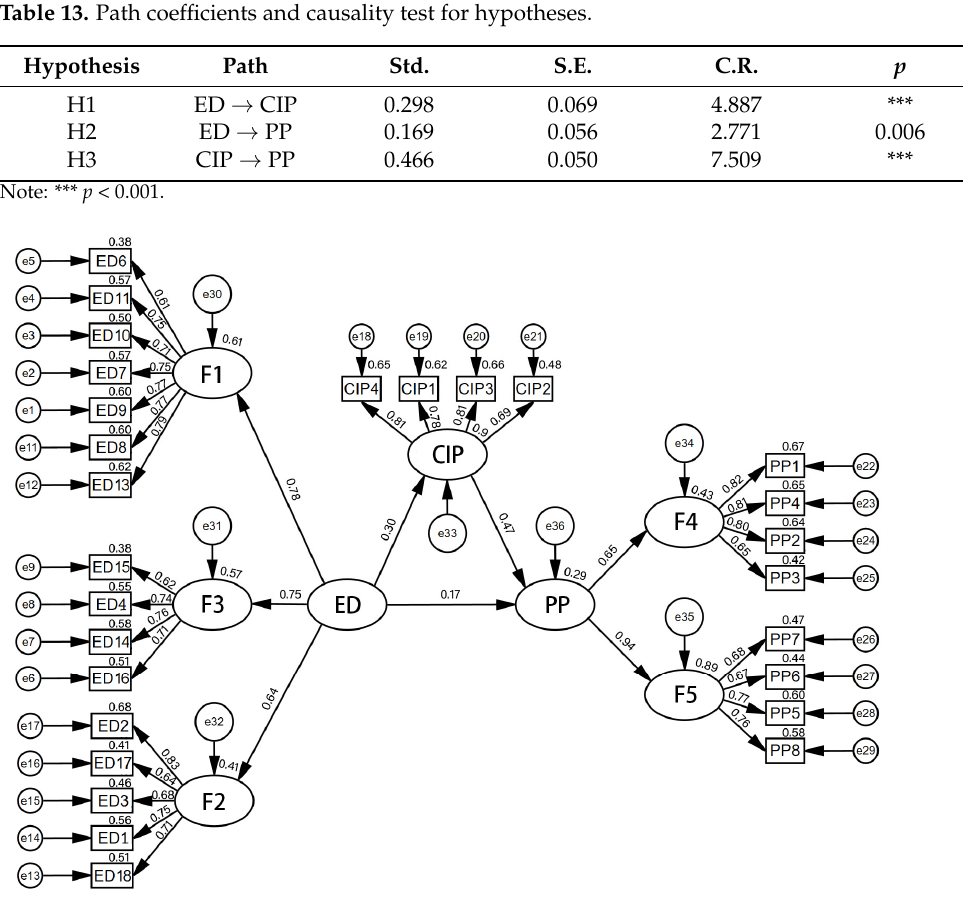
Figure 7. Structural model with path